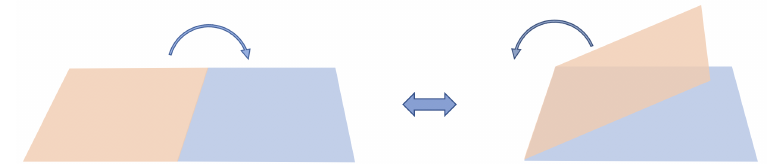
Figure 6. Folding a defect CFT into a boundary CFT. Reflection and transmission coefficients across the defect on the left figure, become a matrix of reflecting boundary conditions on the right